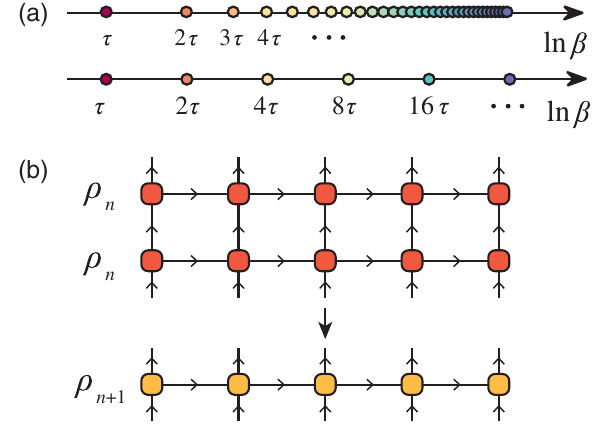
FIG. 2. (a) Linear versus logarithmic temperature scale em- ployed in thermal simulations. (b) A single step in XTRG evolution by projecting MPO ρ n (at β ¼ 2 n τ ) to itself. Following common notation, tensor networks are graphically depicted by blocks (i.e., tensors) connected by lines which are to be contracted. Here, vertical lines indicate physical state spaces, whereas horizontal lines indicate virtual or bond state spaces. The exploitation of symmetries, quite generally, mandates directed lines; hence, each line carries an